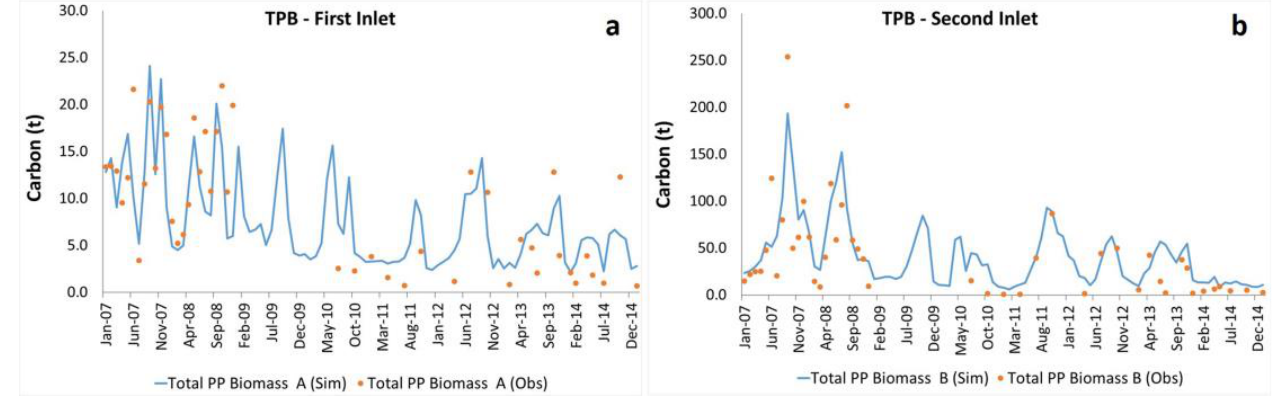
Figure 3. Total phytoplankton biomass (TPB) (t of Carbon) simulated (line) and field data (dots) in the First Inlet ( a ) and in the Second Inlet ( b ) of Mar Piccolo. MPP was the most important component of the community (on average up to 46.5% of TPB) throughout the year and, mainly in the SI, they gave rise to blooms due to diatoms (up to 442.3 µ g C L − 1 in July 2008) (Figure 4).